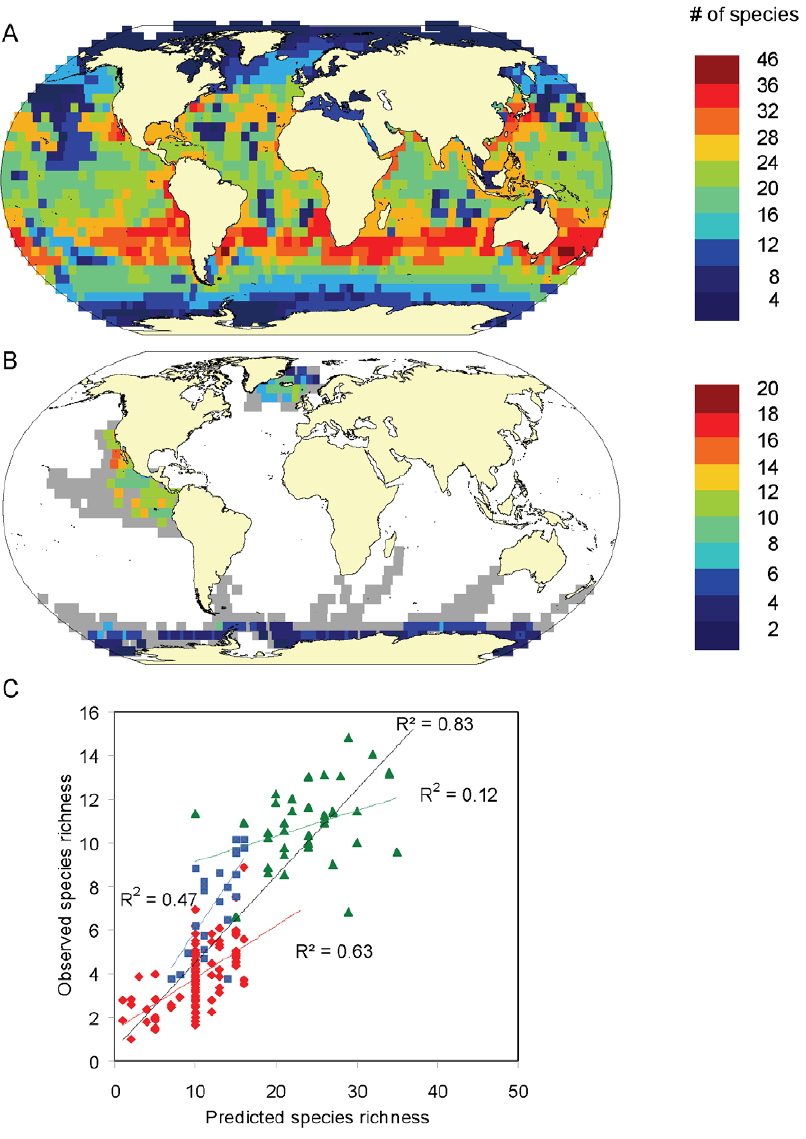
Figure 4. Validation with empirically observed marine mammal occurrences (5 6 x5 6 cells, 1990–1999). A. Predicted species richness of all cetaceans (RES presence threshold . 0.6), B. Observed cetacean species richness per standardized sample of 50 sightings (grey cells have been covered by surveys but had insufficient effort for analysis), C. Relationship between observed and predicted species richness in the Antarctic (red), North Atlantic (blue) and Eastern Tropical Pacific (green) and across all three surveys (black). Data points correspond to individual 5 u grid cells, regression lines to best linear fits, r 2 values were corrected for spatial autocorrelation.